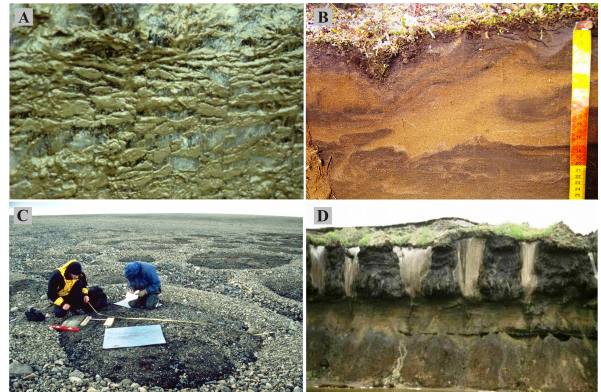
Figure 1. Results of cryopedogenic processes in permafrost. (A) Segregated ice, Lena River Delta, Siberia 2007. (B) Cryoturbation in the top soil of a Gelisol (Typic Psammoturbel), Arga Complex, northwestern Lena River Delta, Siberia 2009. (C) Sorted circles (frost patterns) formed by frost sorting, Brøgger Peninsula, Spits- bergen 1999. (D) Ice wedges, cliff exposure at the Olenyokskaya Channel, Lena River Delta, Siberia 2007. Photo C by Julia